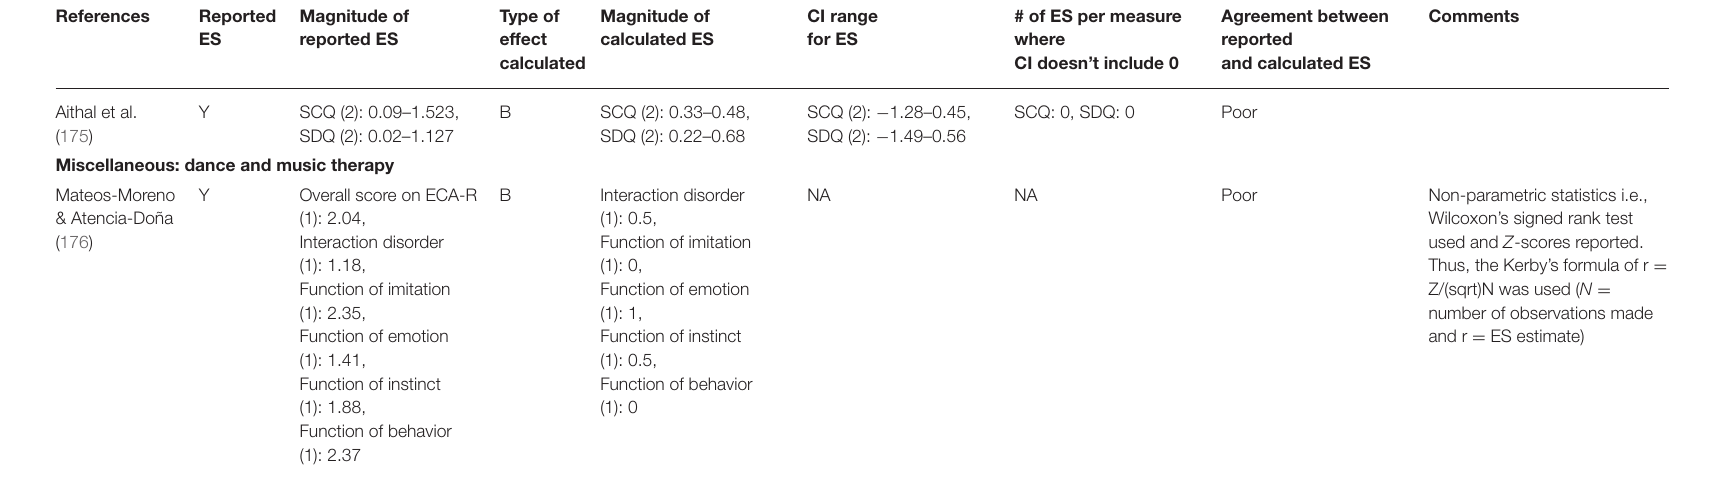
Effect size (ESs) have been calculated and reported only for variables and measures where significant effects were reported in the original study. Effect sizes have been reported as absolute values in terms of magnitude only (for instance, for some variables a negative ES implies improvement. The numbers in parentheses reported next to the measure in columns 4–6 indicate the number of effect sizes calculated per measure. In case of multiple effect sizes calculated per measure, an ES range has been reported. Whenever possible, an attempt was made to triangulate ES values (for instance, if the study provide p-, t-, and/or F-values, ESs were calculated using all methods and checked for agreement). In addition, we have also reported Confidence intervals (CI) for effect sizes. In cases where multiple effect sizes have been calculated per outcome measure, CI ranges have been reported. Lastly, we have also mentioned the number of statistically significant effect sizes (CI do not include 0) per outcome measure for each study. In papers that used multiple control groups, results are reported only from the ASD groups that received creative movement interventions. EG, Experimental Group; CG, Control Group; ES, Effect Size; NA, Not Applicable; NC, No Comparison Possible Since Original Paper did not report effect size estimates; B, Between-group; W, Within-group; N, No; Y, Yes; CI, Confidence Interval; FUP, Follow-up; CRASS, Checklist for Communicative Responses/Acts Score Sheet; CGI-S, Clinical Global Impressions-Severity; CGI-I, Clinical Global Impressions-Improvement; BPRS, Brief Psychiatric Rating Scale; PDDBI-C, Pervasive Developmental Disorder Behavior Inventory-C; ESCS, Early Social Communication Scales; RJA, Responding to Joint Attention; IJA, Initiation of Joint Attention; CARS-BR, Childhood Autism Rating System-Brazilian version; IPR, Index of Peer Relations; RSES, Rosenberg Self-Esteem Scale; STAI-C, State Trait Anxiety Inventory (State and Trait scales); VSEEC, Vineland Social-Emotional Early Childhood Scales; SRS, Social Responsiveness Scale; Mac-CDI, MacArthur Bates Communicative Development Inventories; PCRI, Parent-child Relationship Inventory; MTDA, Music Therapy Diagnostic Assessment; ATEC, Autism Treatment and Evaluation Checklist; JA/ JTAT, Joint Attention; SSRS, Social Skills Rating System; RBS, Repetitive Behavior Scale; BOT-2, Bruininks-Oseretsky Test of Motor Performance-2nd Edition; FMCC, Fine Manual Control Composite; FMP, Fine Motor Precision; FMI, Fine Motor Integration; BCC, Body Coordination Composite; IPS, Interpersonal Synchrony; ADOS, Autism Diagnostic Observational Schedule; QOL, Quality Of Life; K-SSRS, Social Skills Rating System-Korean Version; SPRS, Social and Parent Relationship Scale; PANAS-C, Positive and Negative Affect Schedule for Children; MABC-2, Movement Assessment Battery 2nd Edition; SDQ, Strengths and Difficulties Questionnaire; AI, Attunement Index, TAI, Therapist Attunement Index; DUACS, Duke University Autism Communication and Socialization; ARI-E2, Autism Research Institutes form E2 Checklist; ITB, Imitation Test Battery; RSB, Repetitive and Stereotyped Behavior Test Battery; GM, Gross Motor BASC-2, Behavior AssessmentSystemforChildren-SecondEdition;ABC-C,AberrentBehaviorChecklist-Community;AQ,AutismQuestionnaire;MAAS,MindfulAssessmentandAwarenessScale;PSWQ,PennStateWorryQuestionnaire;RRS,Ruminative Response Scale; WHO-5, World Health Organization-Five Well Being Index; FFMQ, Five Facet Mindfulness Questionnaire; IM-P, Interpersonal Mindfulness in Parenting Scale; PSI-C, Parenting Stress Index-Competence Scale; TSSA, Treatment and Research Institute for ASD Social Skills Assessment; MFMS, Modified Facial Mood Scale; EEG, Electroencephalogram; GARS, Gilliam Autism Rating Scale; NEPSY, Neuropsychological Measures; TOL, Tower of London; CCTT-T2, Children Color Trail Test; FPT, Five Point Test; BL, Bilateral; DSM, Diagnostic and Statistical Manual of Mental Disorders; BRIEF-2, Behavior Rating Inventory of Executive Function-2nd Edition; MVPA, Moderate to Vigorous PhysicalActivity;SSIS-RS,SocialSkillsImprovementSystemRatingScale;GEC,GlobalExecutiveComposite;EDI,EmoryDyssemiaIndex;BDI-Y,BeckDepressionInventory-Youth;CBCL,ChildBehaviorChecklist;DANVA-2,Diagnostic Analysis of Non-verbal Accuracy-2; HSI, Heidelberger State Inventory; SIOS, Social Interaction Observation System; SSRS-T, SSRS Teacher Version; MF, Memory for Faces; MFI, Memory for Faces Immediate; MFD, Memory for Faces Delayed; TOM, Theory of Mind; SSS, Stress Survey Schedule; SSP, Short Sensory Profile; ABAS, Adaptive Behavior Assessment System; PSI, Parent Stress Inventory; PIP, Peer Interaction Paradigm; ERP, Event Related Potential; EQ/SQ, Empathy/Systemizing Quotient; SCERTS, Social Communication, Emotional Regulation and Transactional Support Model; ACPC-DD, Activity Checklist for Preschool Children with Developmental Disability; VABS-2,Vineland Adaptive Behavior Scales; KTK, Korperkoordinationstest fur Kinder; MET, Multifaceted Empathy Test; IRI, Interpersonal Reactivity Index; ASIM, Assessment of Spontaneous Interaction in Movement; HIS, Heidelberg State Inventory; QMT, Questionnaire for Movement Therapy; SA-Q, Self-awareness Questionnaire; EES, Emotional Empathy Scale; FBT, Fragebogen fuer Bewegungstherapie; SANS, Severity of Negative Symptoms; CEEQ, Cognitive and Emotional Empathy Questionnaire; CARS; Childhood Autism Rating System; FIM, Functional Independence Measure; WHODAS, WHO Disability Assessment Scale; EAT, Equine Assisted Therapy; ECA-R, Evaluation of Autistic Behavior-Revised Version; SCQ, Social Communication